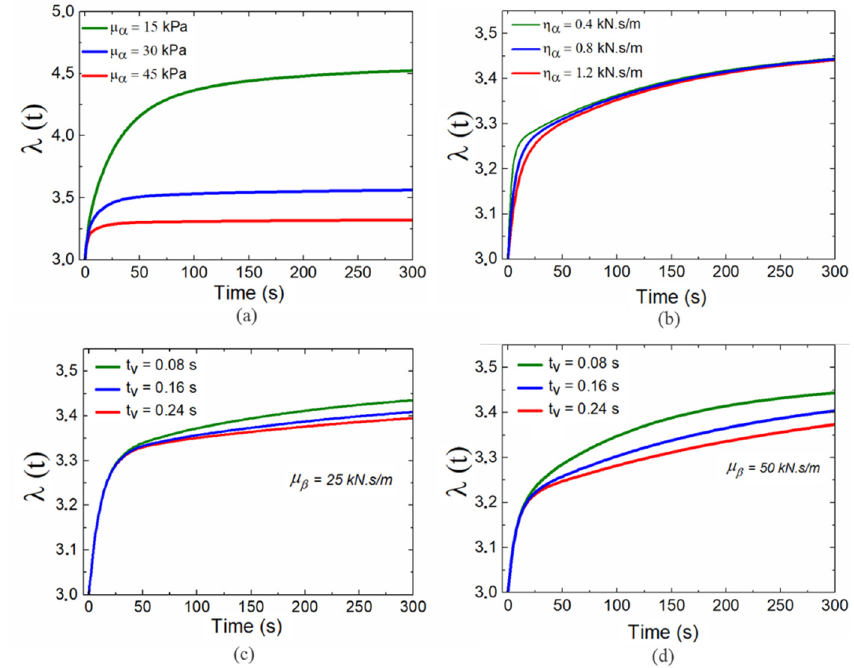
Figure 8. The influence of model parameters in step response: ( a ) the response of the model under different shear modulus of the spring α s , ( b ) the response of the model under different viscous damping of the dashpot α d , ( c ) the response of the model under different relaxation time with µ β = 25kN.s/m, ( d ) the response of the model under different relaxation time with 50kN.s m .